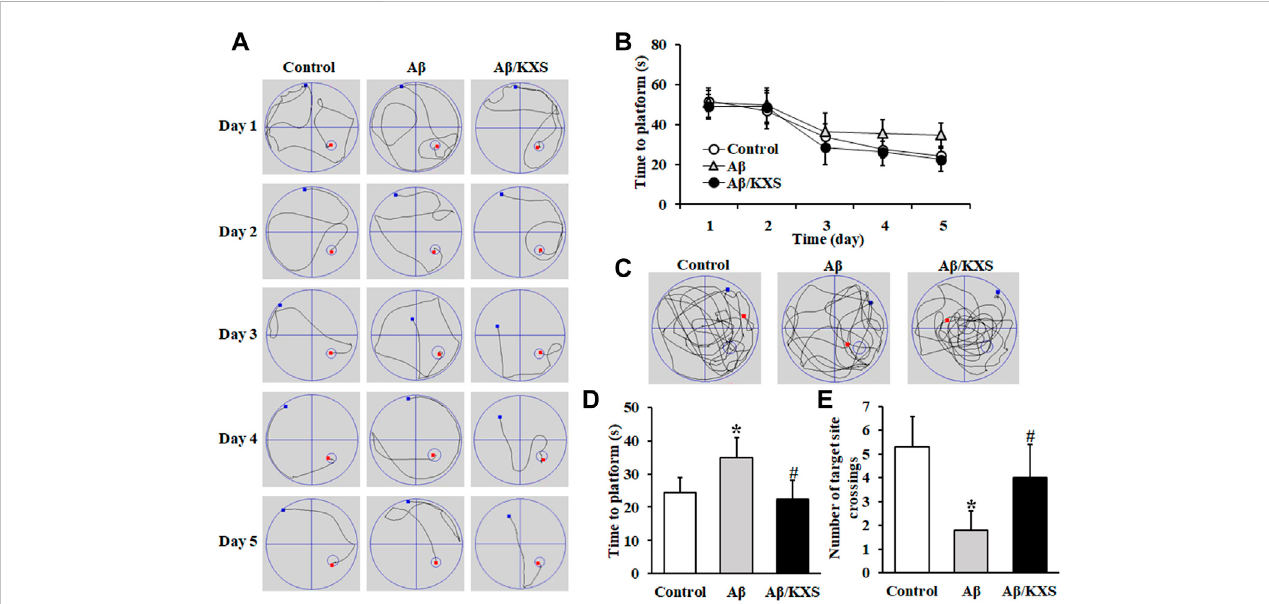
FIGURE 1 EffectofKXSonlearningandmemoryofmodelmice. (A) Representativeswimmingtracesofacontrolmouse( Left ),anA β mouse( Middle ),andanA β /KXS mouse ( Right )during the training phase. (B) Time taken to fi nd the hidden platform during fi veconsecutive days of thepositioning sailing training. There were signi fi cant differences in the time taken to fi nd the platform in all groups on days 4 and 5. (C) Representative swimming traces of a control mouse ( Left ), an A β mouse( Middle ),andanA β /KXSmouse( Right )duringthetestphase. (D) Statisticalcomparisonofthetimetakento fi ndtheplatformonday5. (E) Number of mice crossing the target site; n = 10 per group. Each column with a bar represents the mean ± SD. * p < 0.05, compared with the control group; # p < 0.05 compared with the A β group. A β , amyloid- β ; KXS, Kaixin-San.